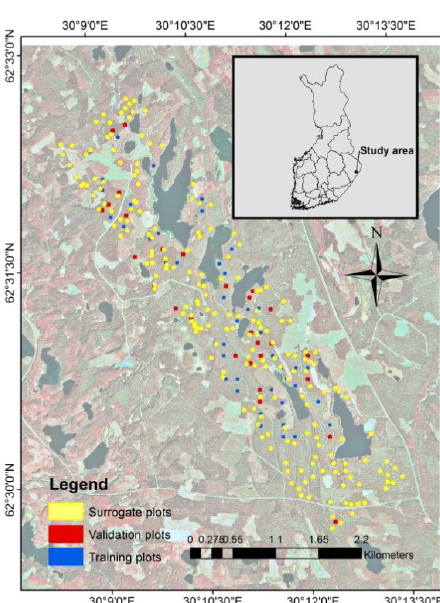
Figure 1. Training, surrogate and validation plots location and administrative map of Finland (left side), and RapidEye image with study area marked (right